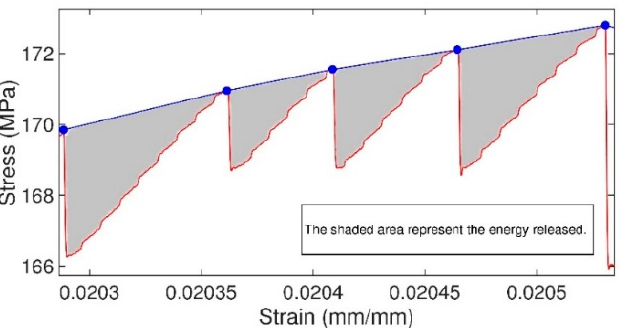
Figure 14. Determination of the energy released due to the PLC phenomenon.